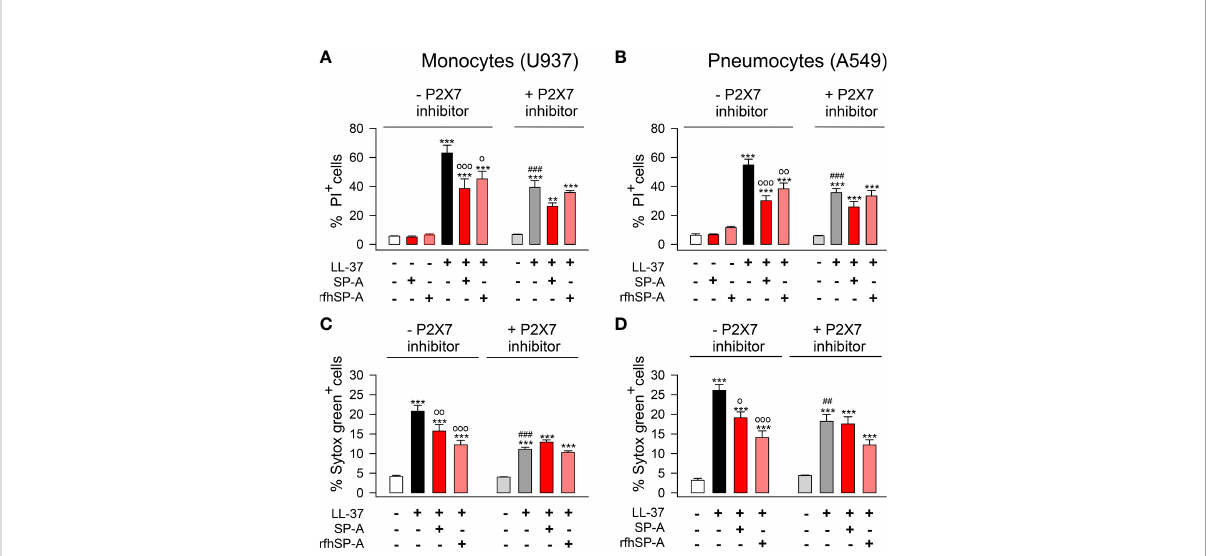
FIGURE 11 SP-A and rfhSP-A diminish the activation of P2X7 channels induced by LL-37 in pneumocytes and monocytes. (A, C) human U937 monocytes and (B, D) A549 pneumocytes were pre-treated with 10 µM A-438079, an inhibitor of the purinergic receptor P2X7, or with its vehicle (DMSO) for 15 min at 37°C. Then, cells were incubated with LL-37 (2.5 µM) in the presence or absence of SP-A (0.15 µM) and rfhSP-A (0.88 µM) for 1 hour. The entry of PI (A, B) or Sytox Green (C, D) to the cells was determined by fl ow cytometry. The P2X7 channel inhibitor partially reduced the entry of PI or Sytox Green induced by LL-37. Results are means ± S.E.M. offour different cell cultures, each with three biological replicates. For statistical analysis, ANOVA followed by Bonferroni multiple comparison test was used. **p < 0.01, ***p < 0.001 when LL-37-treated samples are compared with untreated controls.